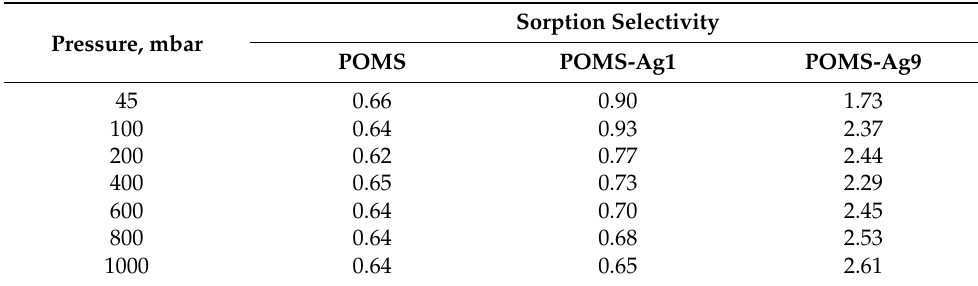
Table 2. Sorption selectivity for the ethylene/ethane, depending on the pressure in the obtained membrane